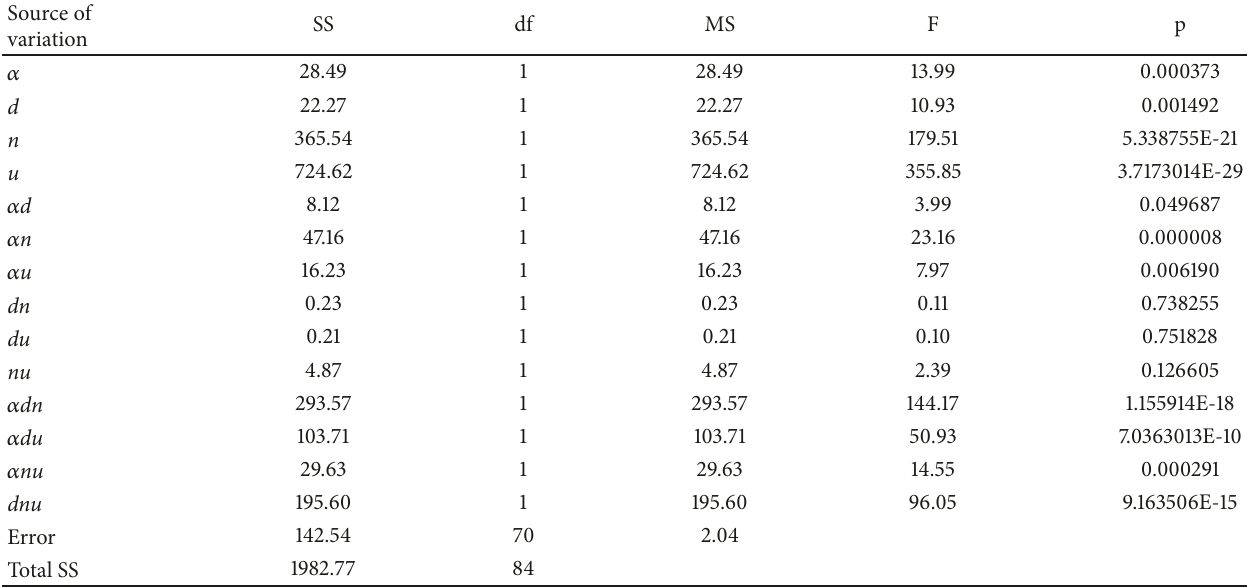
Table 2: Analysis of variance results of the model of screw drive torque M, wherethe coefficientof determination is R 2 =0.93 and its corrected value is R 2 adj =0.91. SS: sum of squares, df: number of the degrees of freedom, MS: mean sum of squares, F: values of the test statistic, p: value of probability corresponding to the test statistic value.